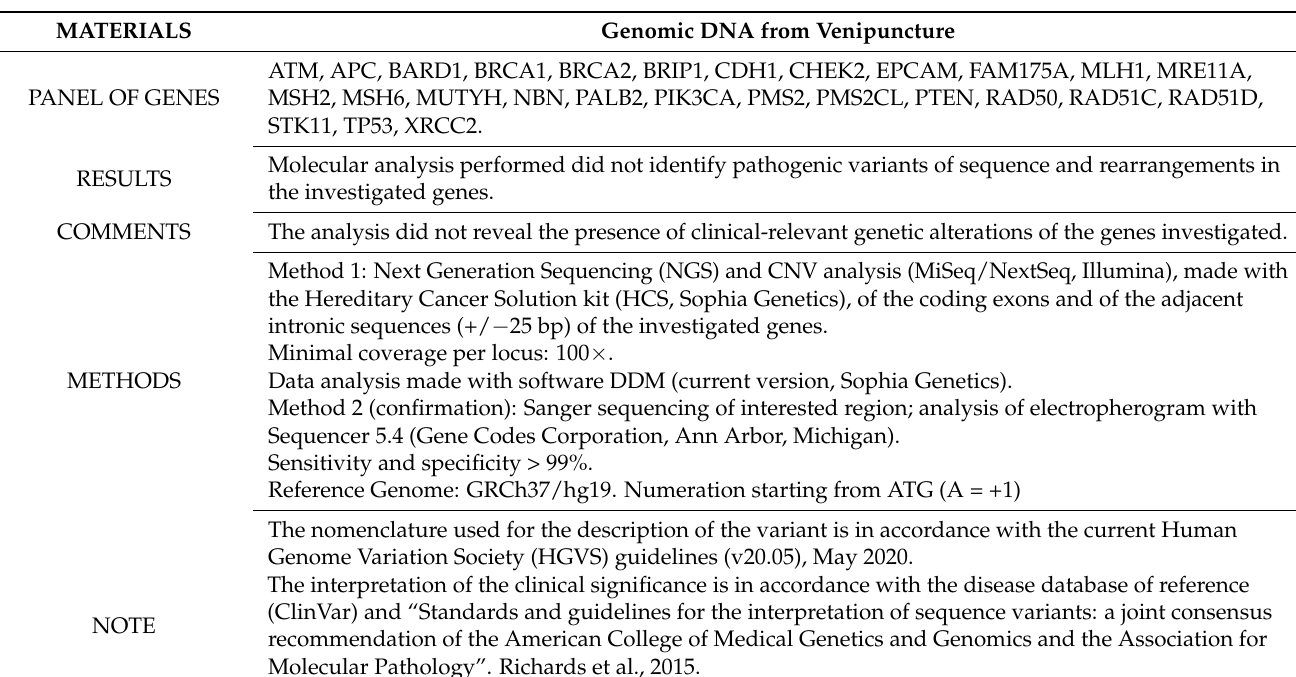
Table 1. Genetic Analysis. Panel of